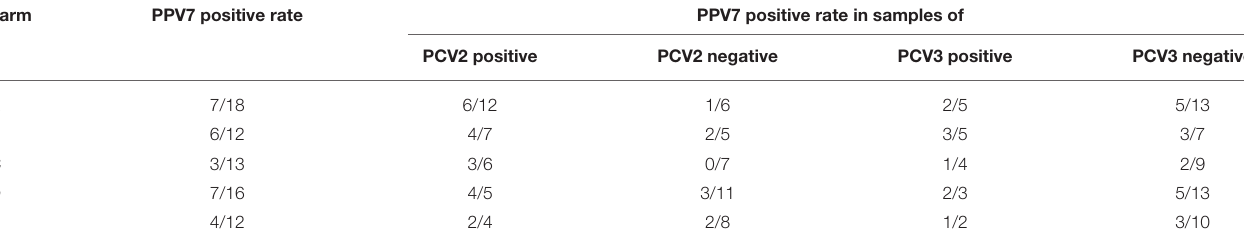
TABLE 2 | Co-infection of PPV7 with PCV2 or with PCV3 in pig farms that are detected positive for PPV7. Farm PPV7 positive